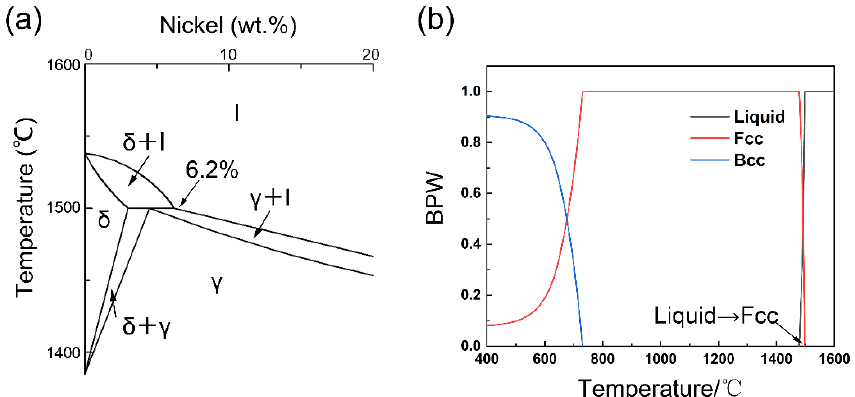
Figure 7. ( a ) The Fe–Ni binary phase diagram [7]; ( b ) the solidification process simulated by the Thermo-Calc.